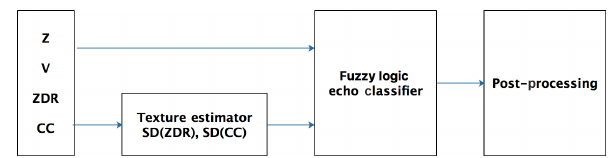
Figure 1. Block diagram of the MetSignal algorithm.